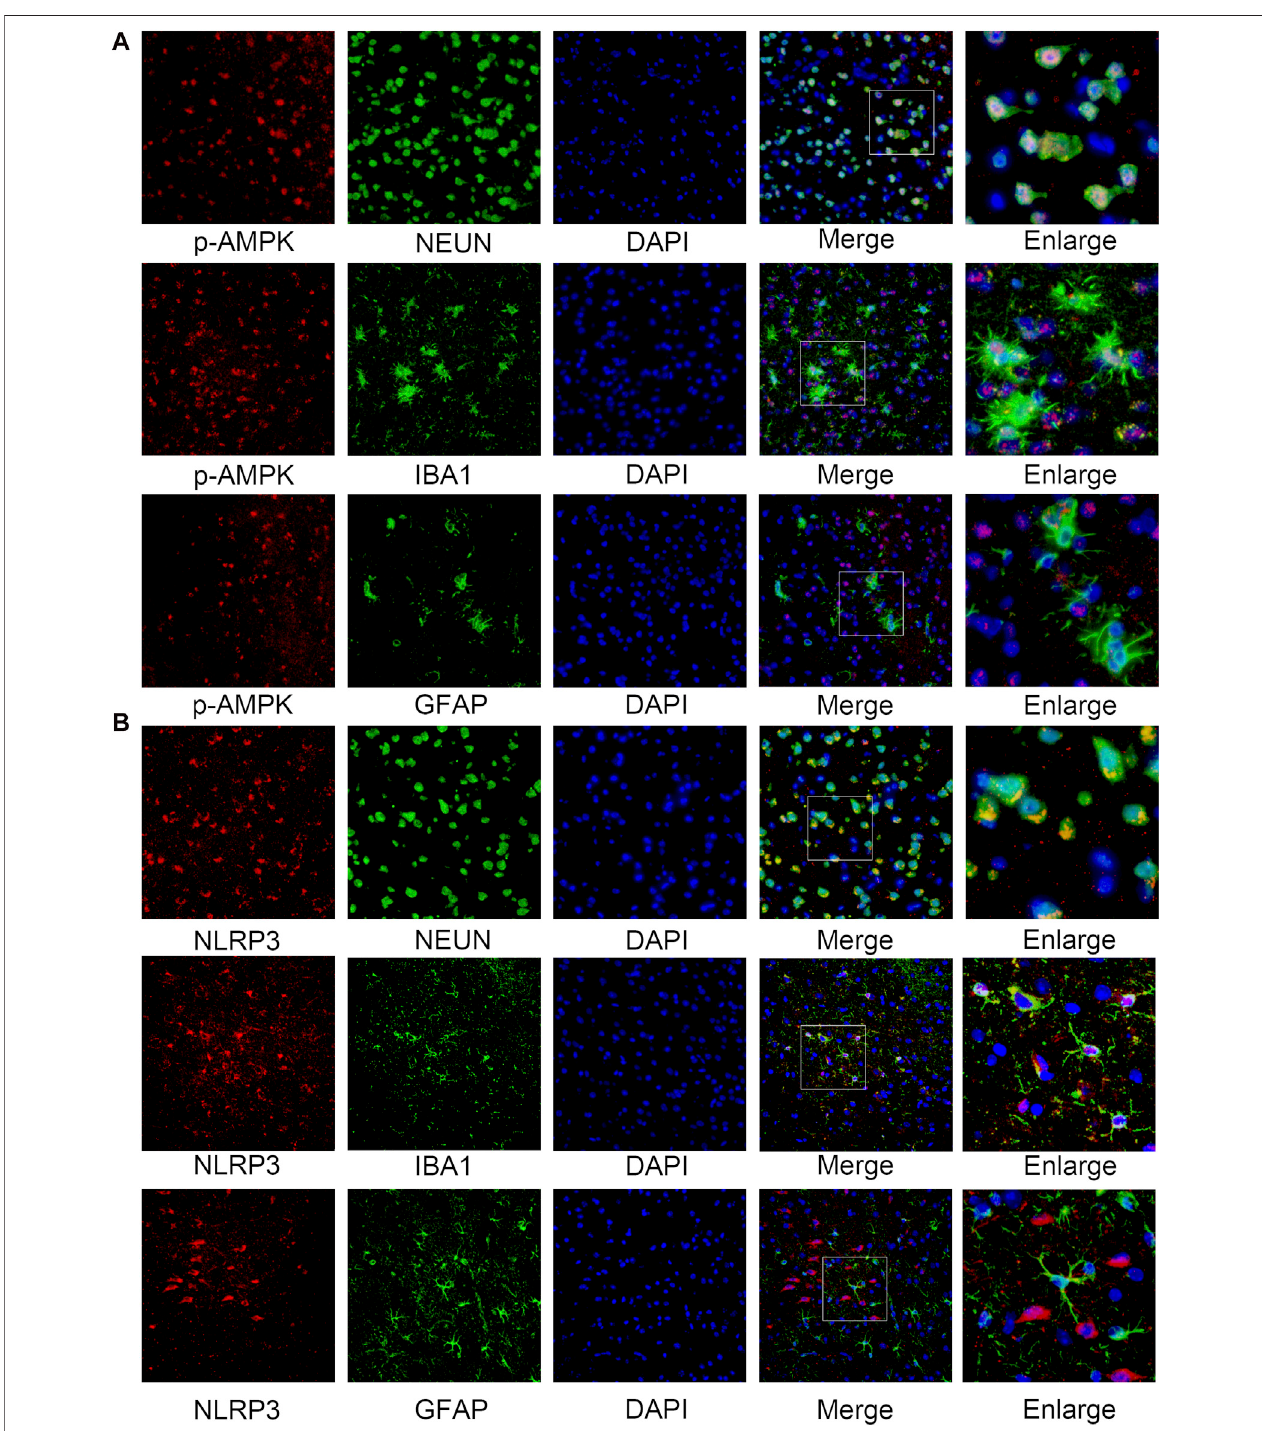
FIGURE3| Cellularlocalizationofp-AMPKandNLRP3intheipsilateralhemisphere24 hafterSAH. (A) Representativeimagesofco-immuno fl uorescencestaining ofp-AMPK(red)withneurons(NEUN,green),astrocytes(GFAP,green),andmicroglia(IBA1,green)intheipsilateralcortexat24 hafterSAH.NucleiarestainedwithDAPI (blue)(Magni fi cation=×400,scalebar =50 um, n =3pergroup). (B) Representativeimagesofco-immuno fl uorescence stainingofNLRP3(red)withthesameaforesaid conditions. Enlarged images come from the areas of a white rectangle within merge images.